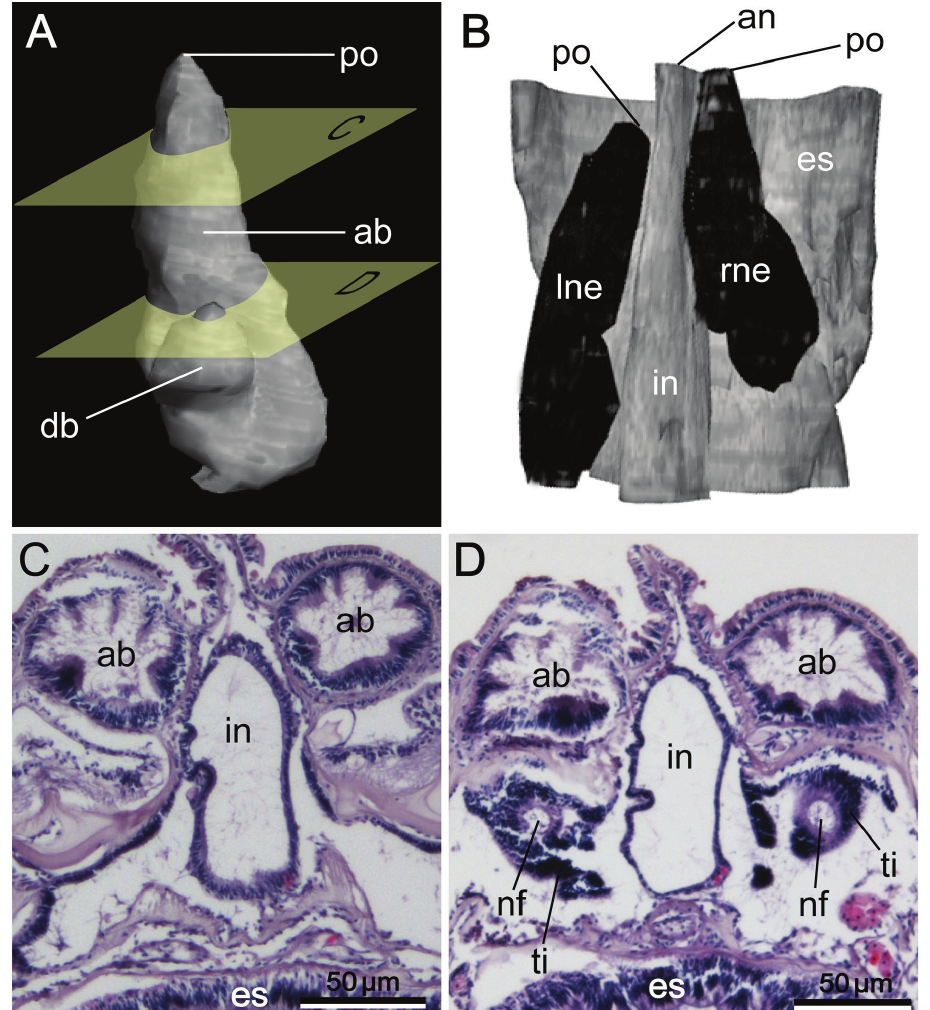
Figure 10. Reconstructed three-dimensional images and transverse sections of the nephridium of Phoronis emigi sp. n., based on NSMT-Te 721 (paratype). A Lateral view, showing the different lengths of the ascending and descending branches B dorsal view, showing the offset arrangement of the nephridia, with the nephridiopores at different levels along the body axis C transverse section through the ascending branch D transverse section through the tip of the descending branch, showing the nephridial funnels. Abbreviations: ab ascending branch; an anus; db descending branch; es esophagus; in intestine; lne left nephridium; nf nephridial funnel; p nephridiopore; rne right nephridium; ti funnel tissue. Planes C and D in panel A indicate the positions of the transverse sections in C and D . Left and right lateral mesenteries present (Fig. 11A). Single giant nerve fiber, 15.98– 36.03 μm in diameter (holotype avg. 27.40±6.29 μm, based on 5 sections from different parts of the body; avg. 25.93±6.05, based on 11 sections from different parts of